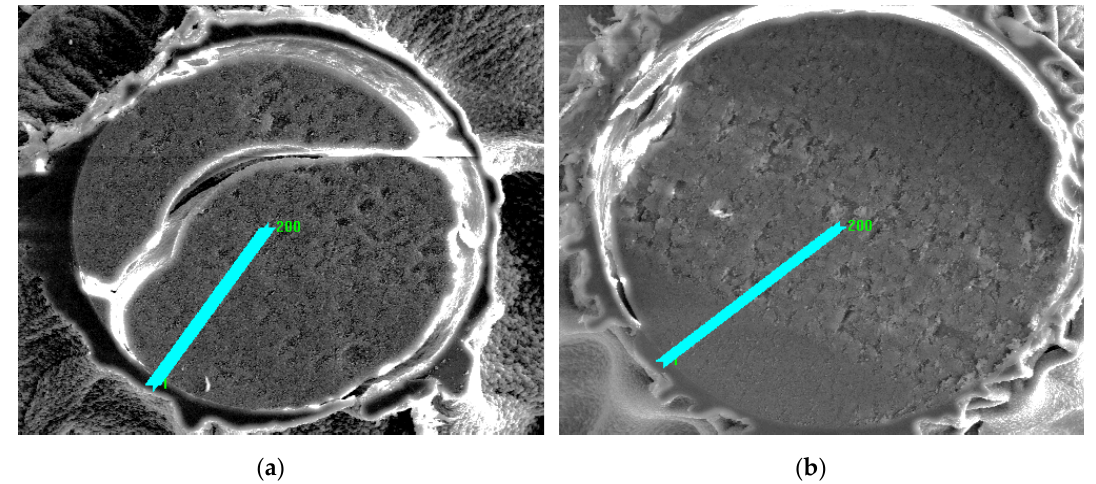
Figure 4. SEM images of cut ( a ) Purolite S 940, ( b ) Purolite S 950 after the Cu(II) ions sorption process.